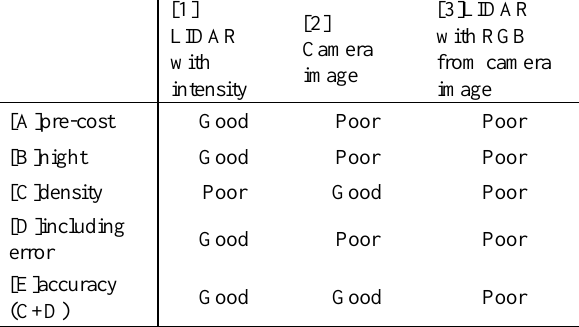
Table 2. Comparison table of